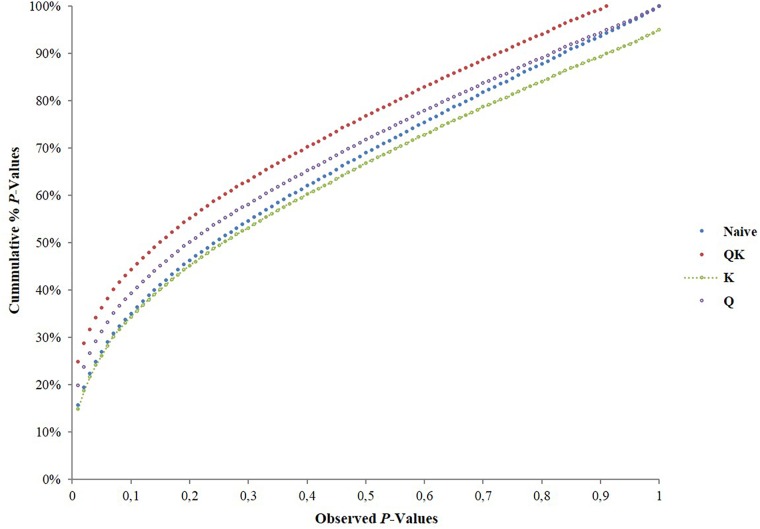
Comparison of four genomes wide association study model: naïve-model (GLM without any correction for population structure); Q-model (GLM with Q-matrix as correction for population structure); QK-model (MLM with Q-matrix and K-matrix as correction for population structure and kinship relationships); and K-model (MLM with K-matrix as correction for kinship relationships structure). Cumulative distribution of P-values was computed from the DNA markers and phenotypes for the different association models.